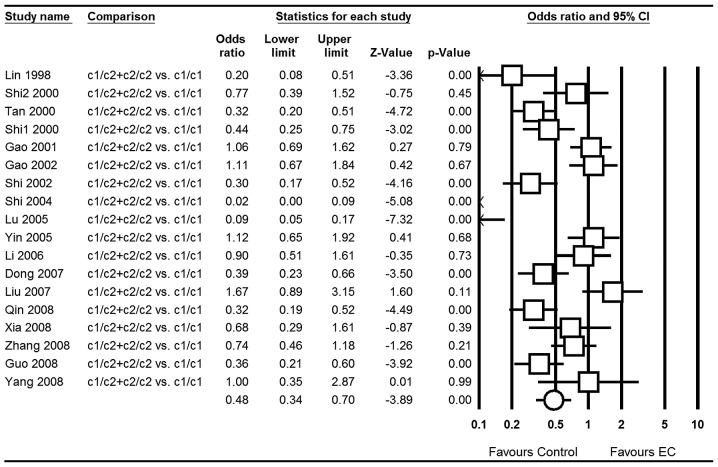
Forest plot of EC associated with CYP2E1 RsaI/PstI for the c1/c2+c2/c2 genotype compared with the c1/c1 genotype in total. CI, confidence interval; EC, esophageal cancer.